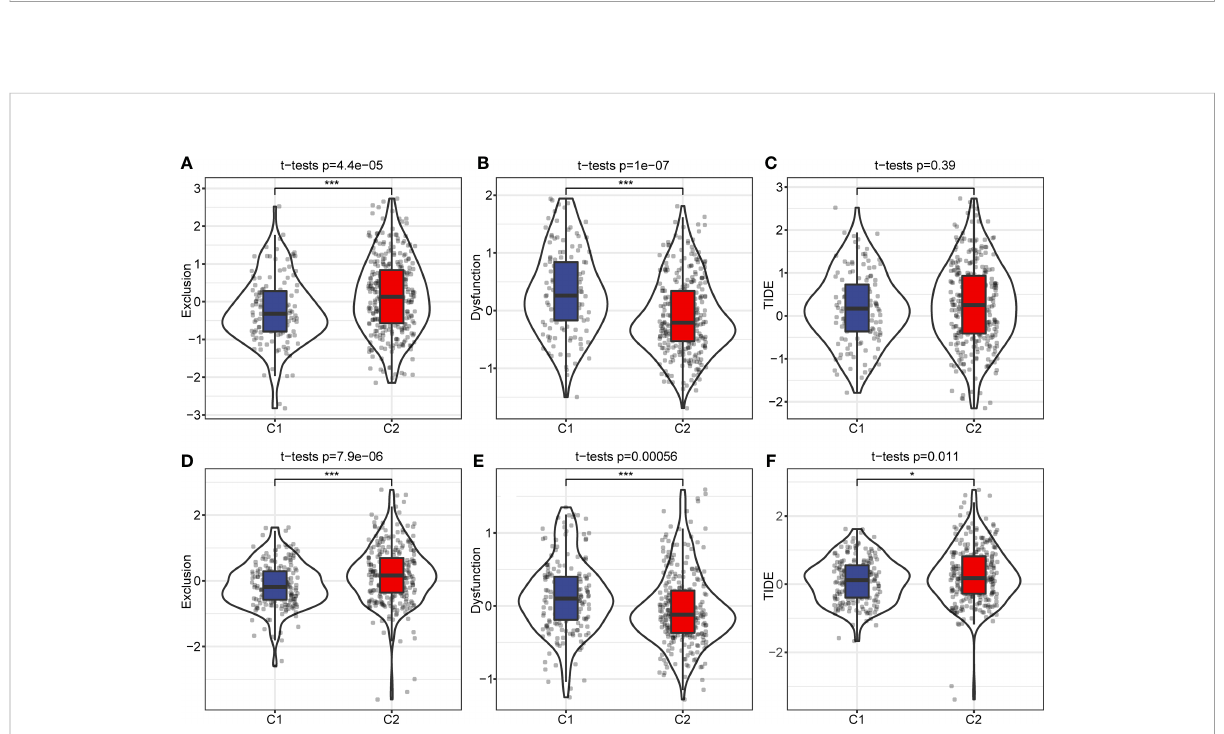
FIGURE 8 TIDE analysis of immune therapy. (A) Exclusion scores among different molecular subtypes in RNA-seq dataset. (B) C1 and C2 subtype dysfunction scores in the RNA-seq dataset. (C) TIDE score of different molecular subtypes in RNA-seq data. (D) Differences of Exclusion scores among different molecular subtypes of the GEO dataset. (E) C1 and C2 subtype Exclusion scores in the GEO dataset. (F) TIDE score of different molecular subtypes in the GEO dataset. * p < 0.05; *** p <